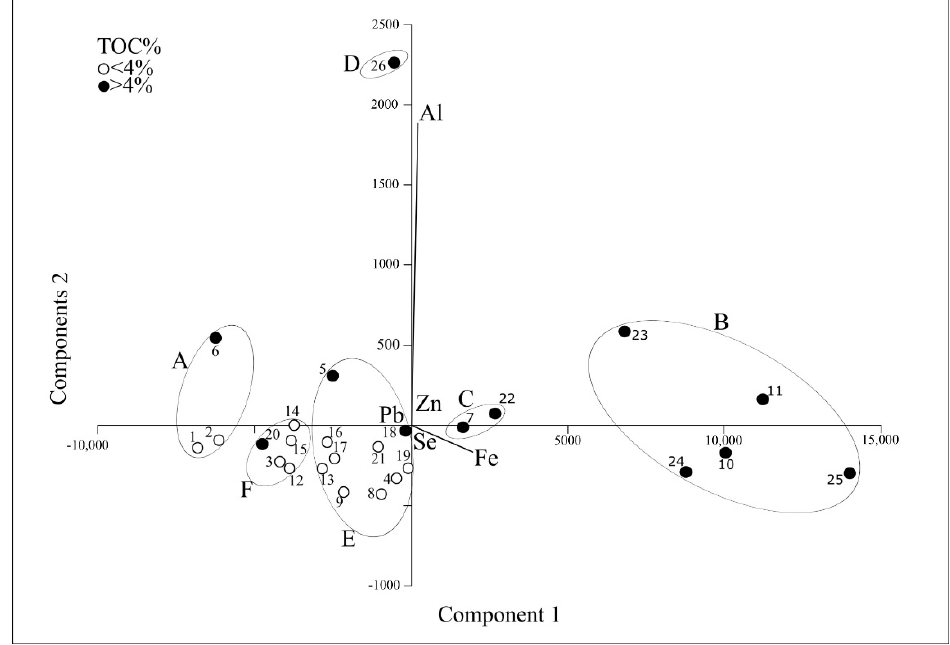
Figure 7. Principal components showing the dominance of PTEs with respect to TOC percentages. Ellipsoids A–F show sample stations with similar concentrations of TOC and dominant PTEs.